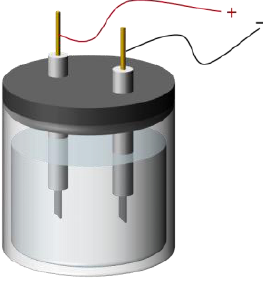
Figure 1. Schematic diagram of electrocoagulation setup.